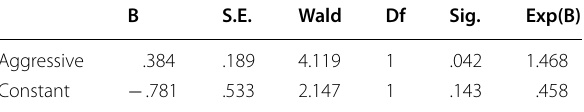
Table P: Variables in the equation for aggressive culture